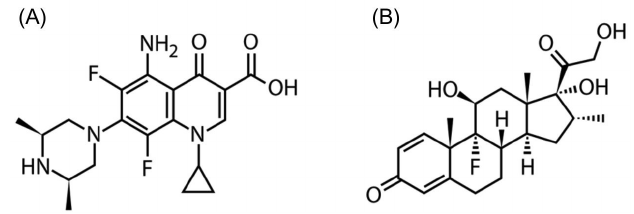
FIGURE 1 - Chemical structures of sparfloxacin (A) and dexamethasone